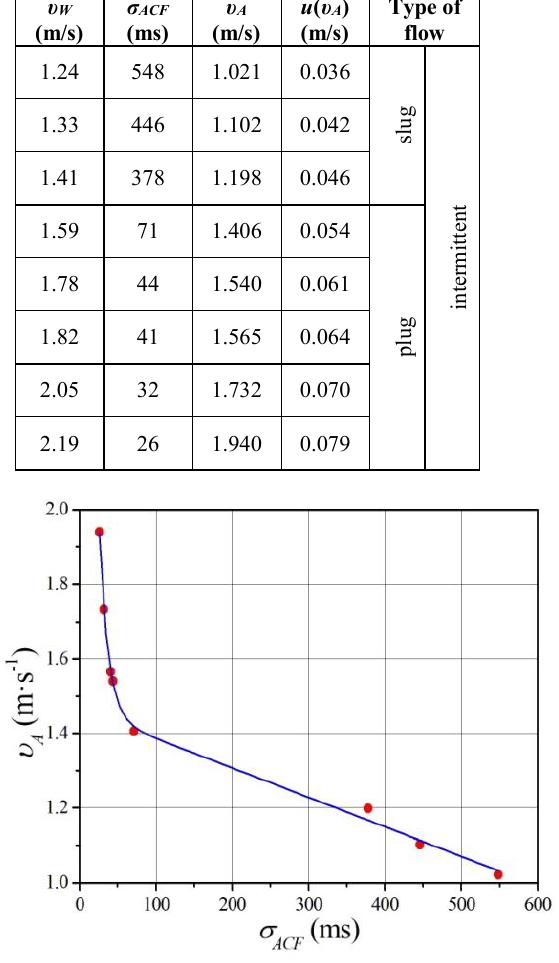
Fig. 5. Calibration curve υ A = f( σ ACF ) Based on the distribution of the points in Fig. 5, the relationship between air velocity and standard deviation σ ACF is obtained: